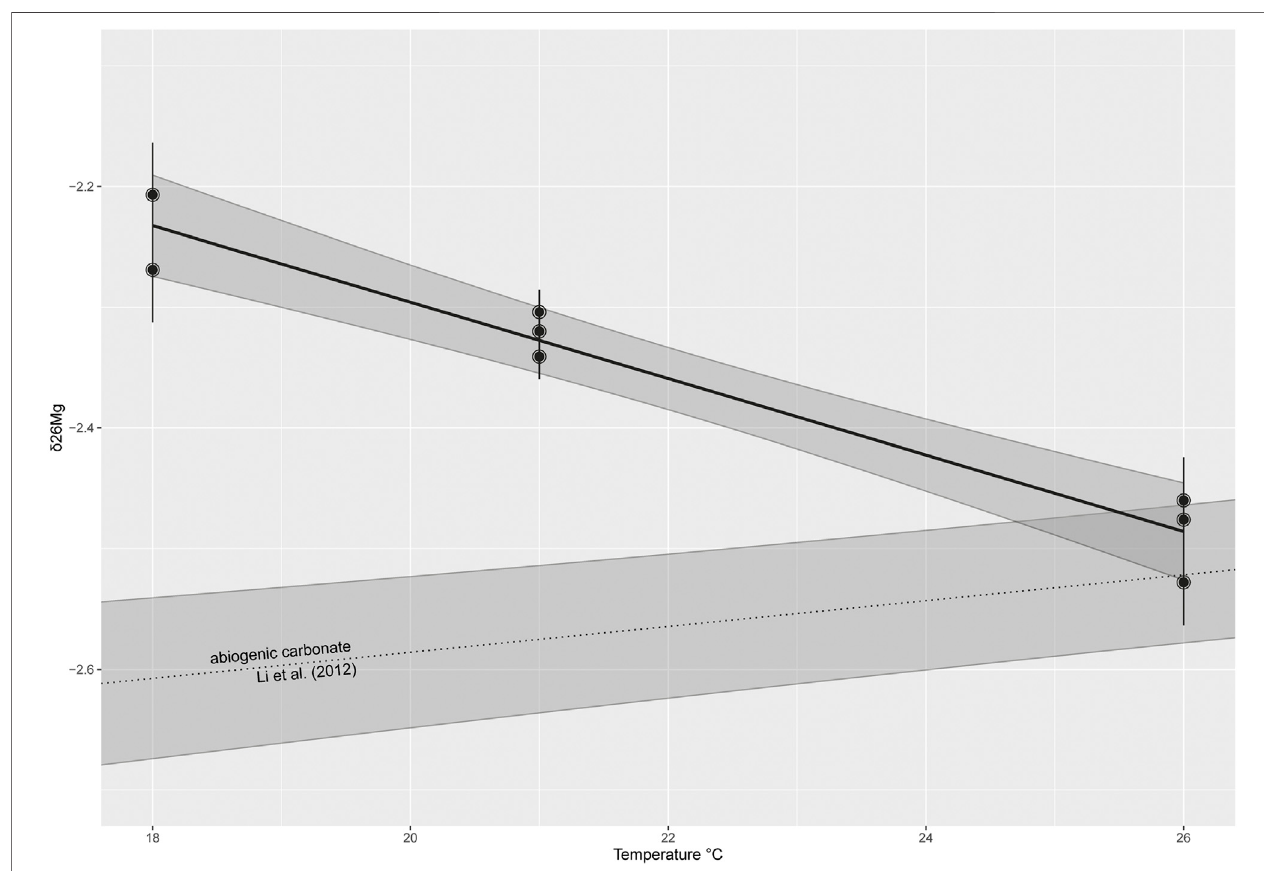
FIGURE 2 | δ 26 Mg values ( ± SD) measured in foraminiferal calcite of cultured Amphistegina lessonii shows a strong, negative correlation with temperature. Since temperature was a controlled variable, errorbars are within the width of the symbol. The grey area indicates the 95% con fi dence interval. The relationship observed can bedescribedas δ 26 Mg (cid:2)− 0.03*T − 1.66( p -value < 0.001,adjusted R 2 (cid:2) 0.93).Thisrelationshipisoppositetotheoneobservedinsomeabiogeniccarbonates(Lietal.,